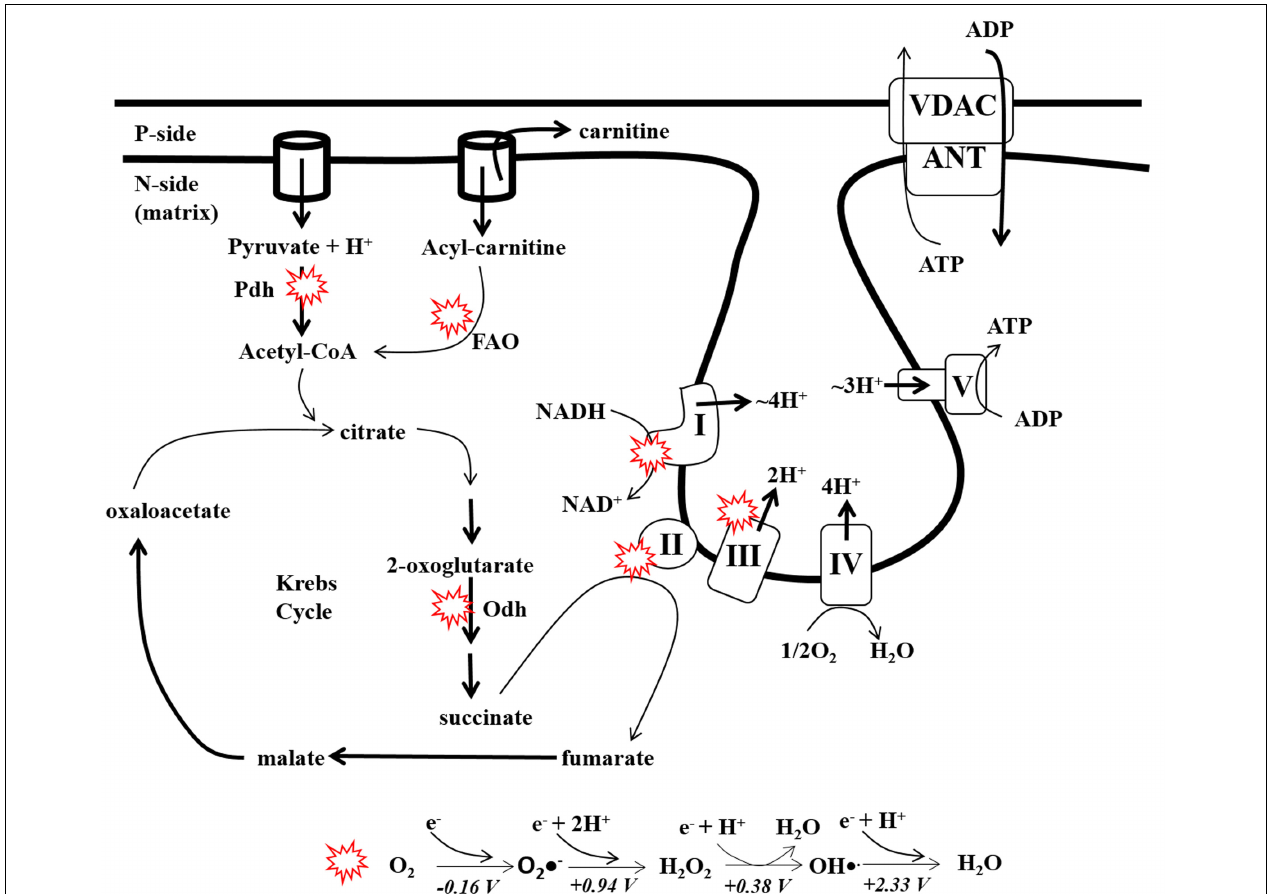
FIGURE 1 | Production of ATP and ROS by the electron transport chain. Nutrients in the form of glucose, fatty acids, or amino acids are converted into the Krebs cycle intermediates and then oxidized by 8 different enzymes. During carbon oxidation electrons are extracted and ferried through the respiratory complexes to drive ATP production (OXPHOS). Electrons from the Krebs cycle enter the respiratory chain via NADH at Complex I or succinate at Complex II. Electron flow to the terminal acceptor di-oxygen which creates the transmembrane